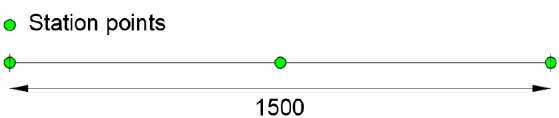
Figure 4. 1st order element with three station points.